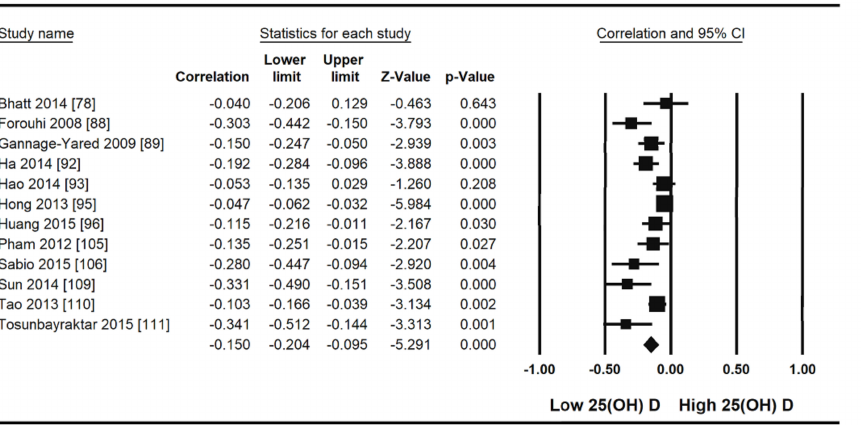
Figure 5. Non-diabetic subject studies for the lowest BMI quartile (18–25): Forest plot showing the relationship of vitamin D status and HOMAIR [78,88,89,92,93,95,96,105,106,109–111].